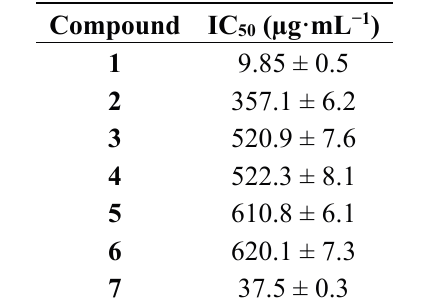
Table 2. IC 50 values of compounds 1 – 7